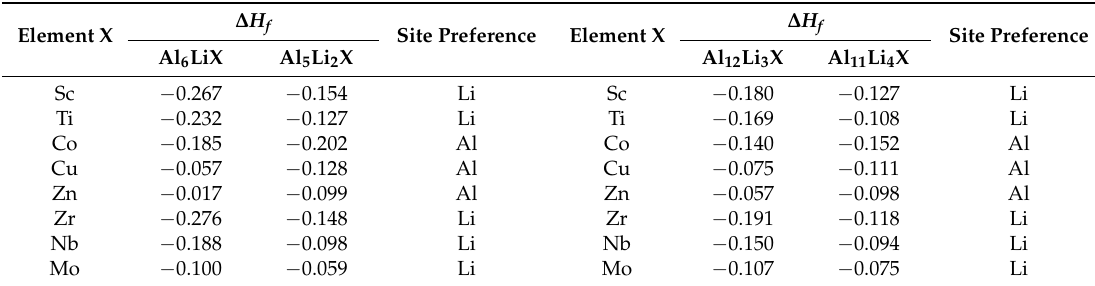
Table 2. Simulated enthalpy of formation ∆ H f (eV) and site occupancy behaviors of doping elements X (X = Sc, Ti, Co, Cu, Zn, Zr, Nb, and Mo) in Al 3 Li at 0